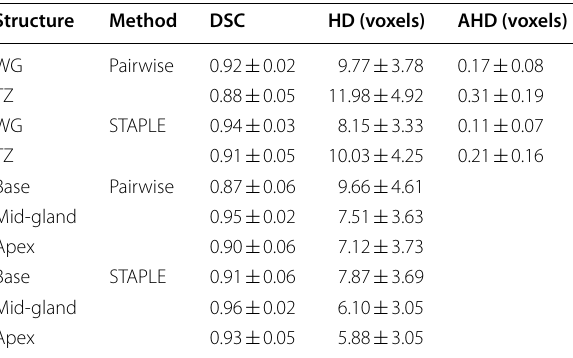
Table 2 Summarized similarity metrics for all radiologists and all structures (WG vs. TZ, and WG divided along cranio‑caudal axis in base, mid‑gland and apex), with 2 methods (pair‑wise comparison and consensus comparison (STAPLE reference)) Structure